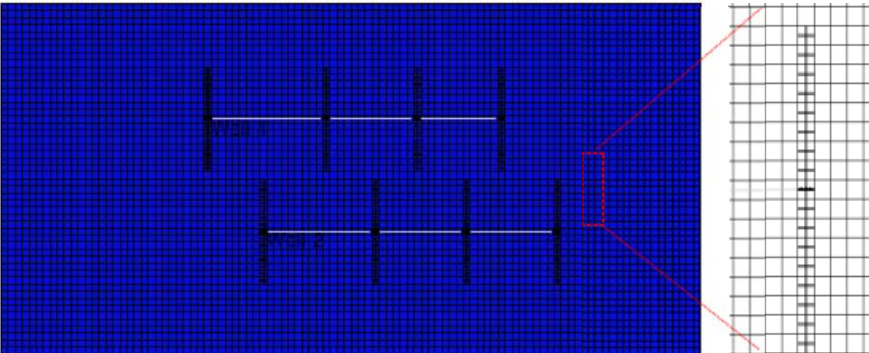
Figure 5. Top view of the numerical model of Case II in CMG module.